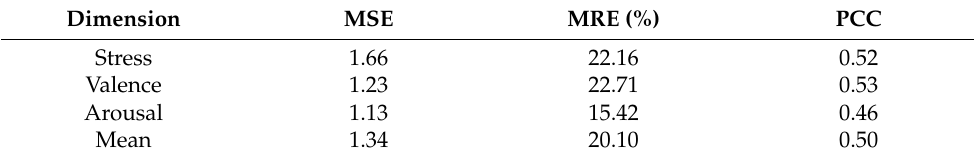
Table 7. Baseline model’s performance on the test set in terms of MSE, MRE and PCC. Dimension MSE MRE (%) PCC Stress 1.66 22.16 0.52 Valence 1.23 22.71 0.53 Arousal 1.13 15.42 0.46 Mean 1.34 20.10